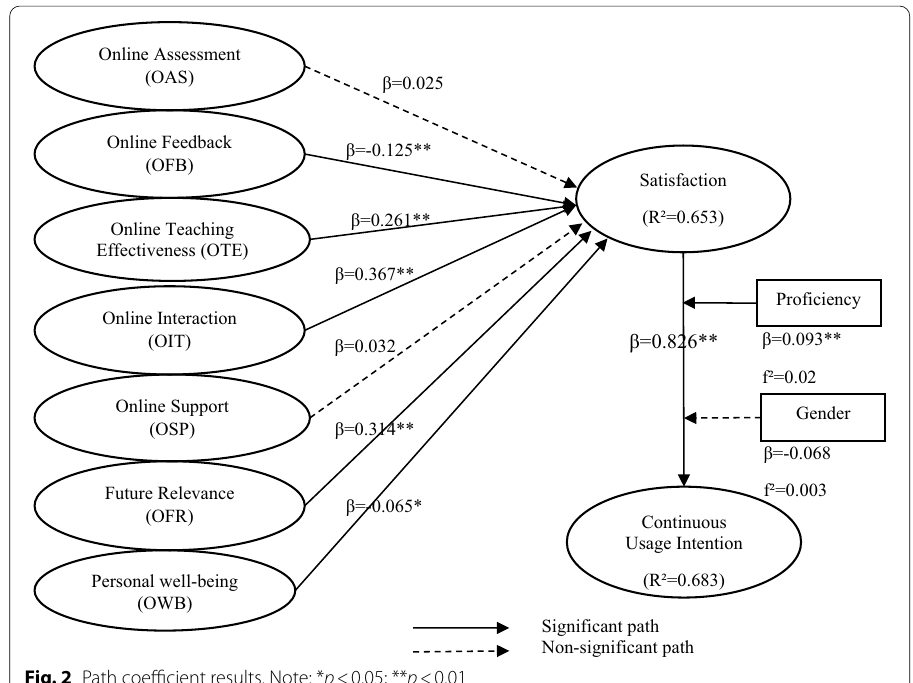
Fig. 2 Path coefficient results. Note: * p < 0.05; ** p <